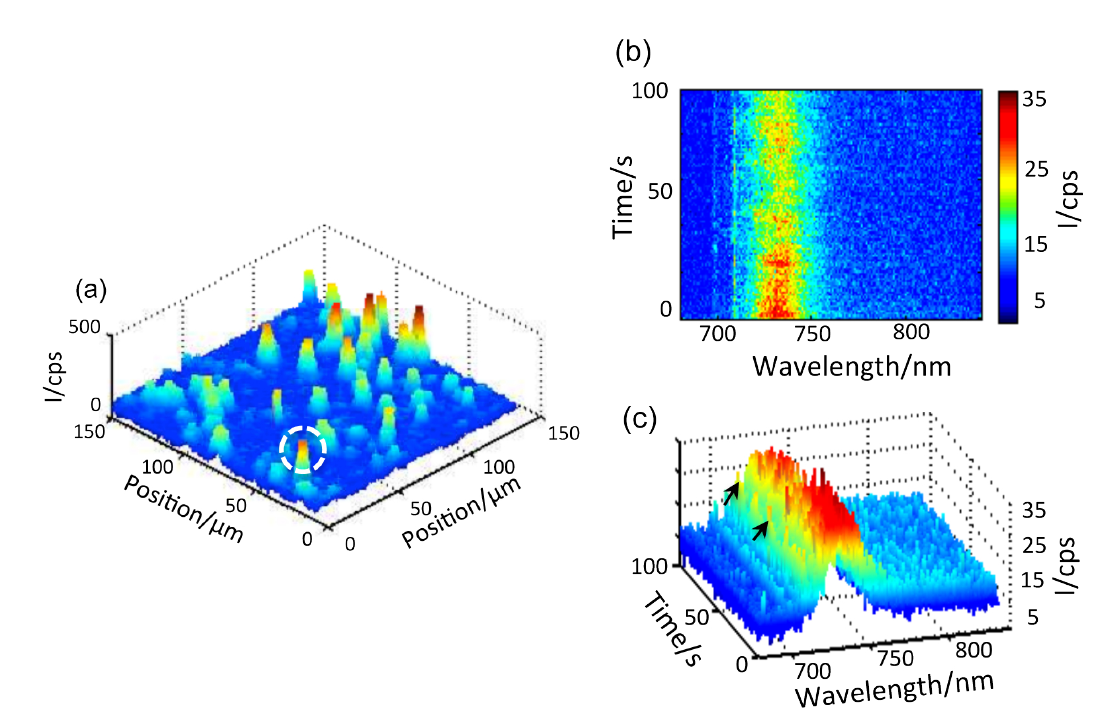
Figure 3. ( a ) Confocal fluorescence 3D scan of PSI-Au/Au. The bright spots, which are visible in almost the entire image range, are from individual PSI-Au/Au pairs. The white circle highlights the exemplary individual pair from which the sequence of spectra are collected. ( b ) The time-dependent dataset consists of 100 fluorescence spectra taken from the highlighted single PSI-Au/Au pair with an integration time of 1 s per spectra. ( c ) The 3D view of the sequence of 100